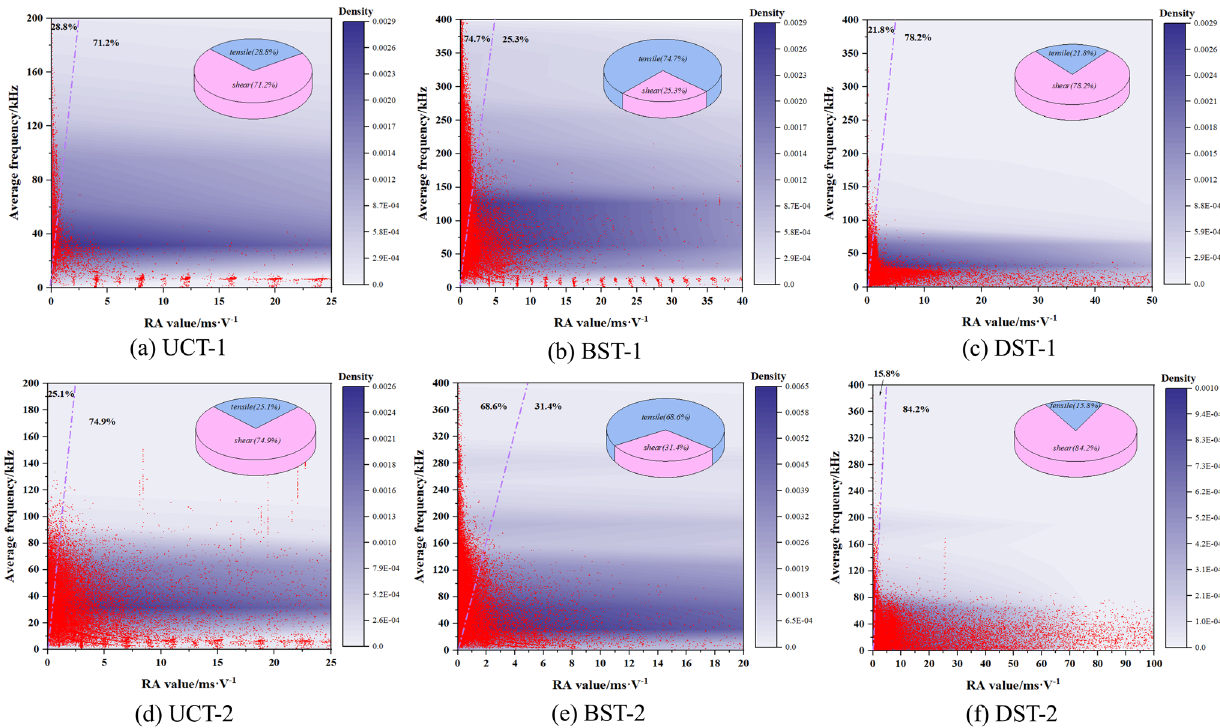
Fig. 5 Distributions of AF - RA : a UCT-1; b BST-1; c DST-1; d UCT-2; e BST-2; f DST-2